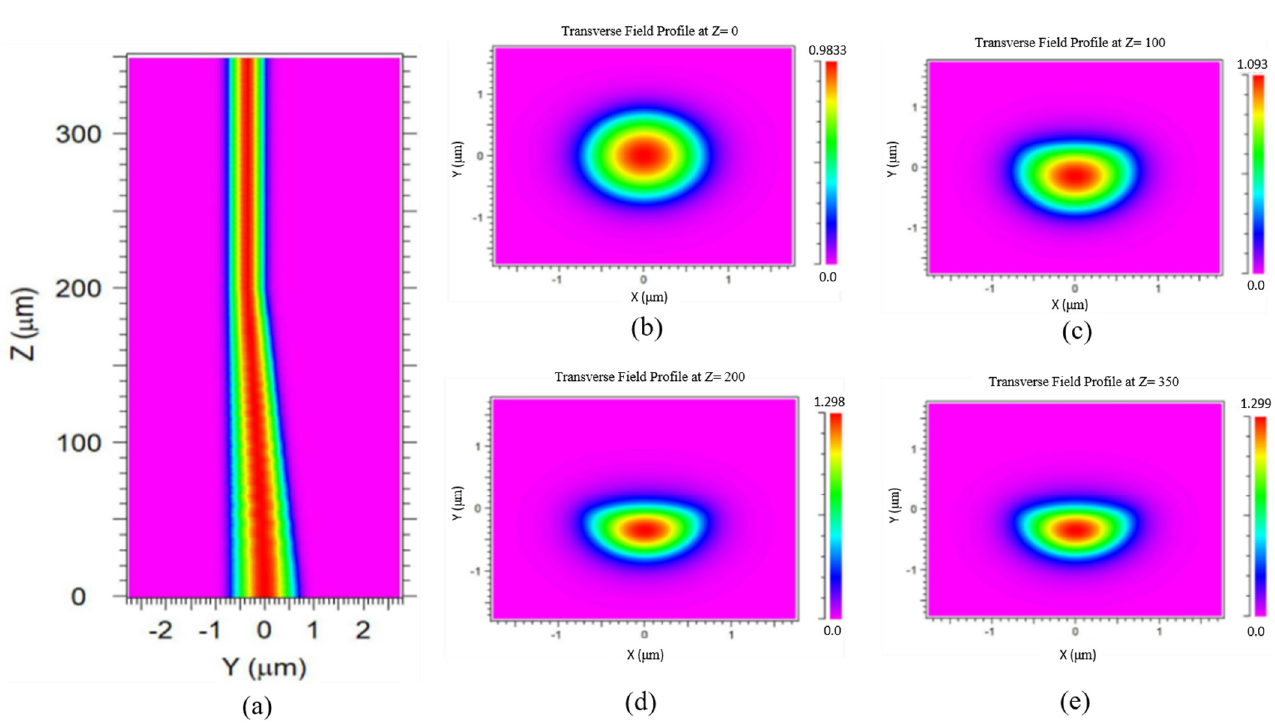
Figure 3. ( a ) The evolution of light field propagating through the DSCF y–z -plane, and light field of x–y -plane at ( b ) z = 0 µm, ( c ) 100 µm, ( d ) 200 µm, and ( e ) 350 µm.